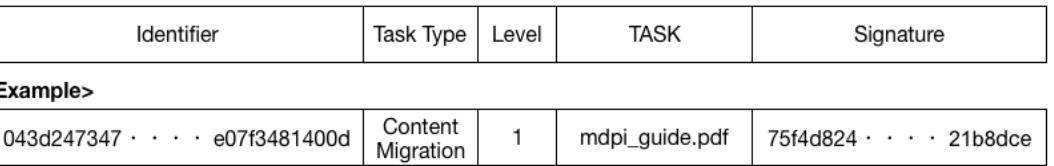
Figure 6. Content type migration request message format and